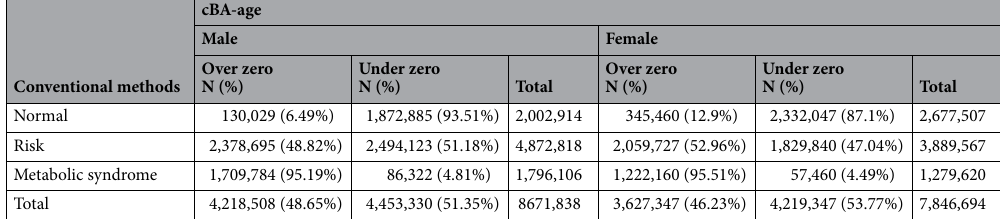
Table 5. The discrepancy between conventional diagnosis of metabolic syndrome and MS BA. All parameters are P < 0.001.